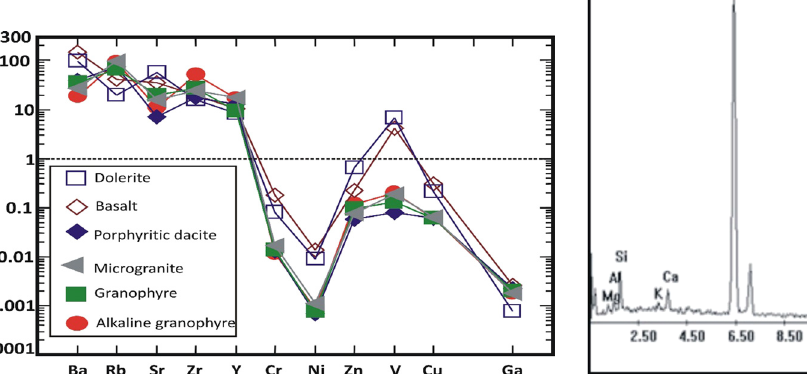
Figure 11: Distribution pattern of trace elements of di ff erent dikes normalized to average primitive mantle ( Taylor and McLennan [ 30 ]) .